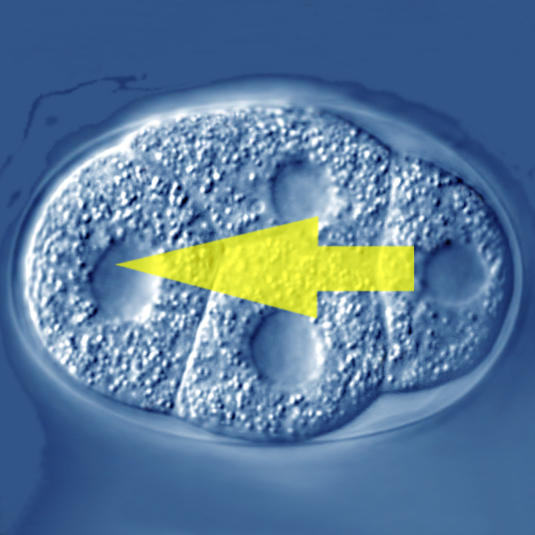
The posterior P2 blastomere polarizes the four-cell embryo, thereby organizing the cleavage directions of cells—which shapes the embryo and directs cell-fate determination.